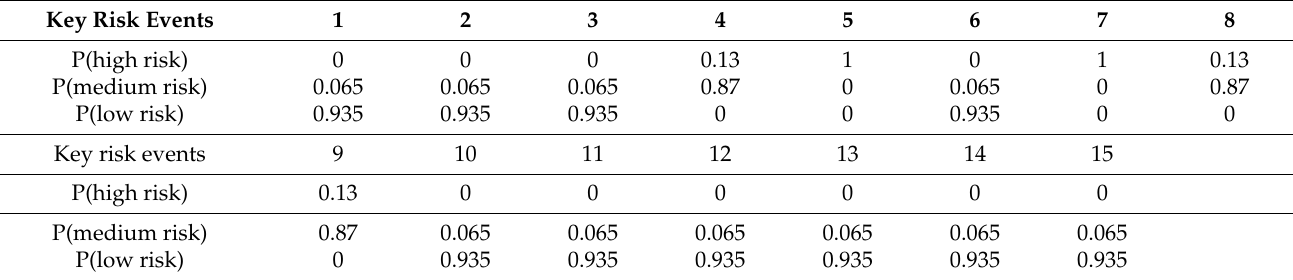
Table 5. Risk level probability of the key risk events.